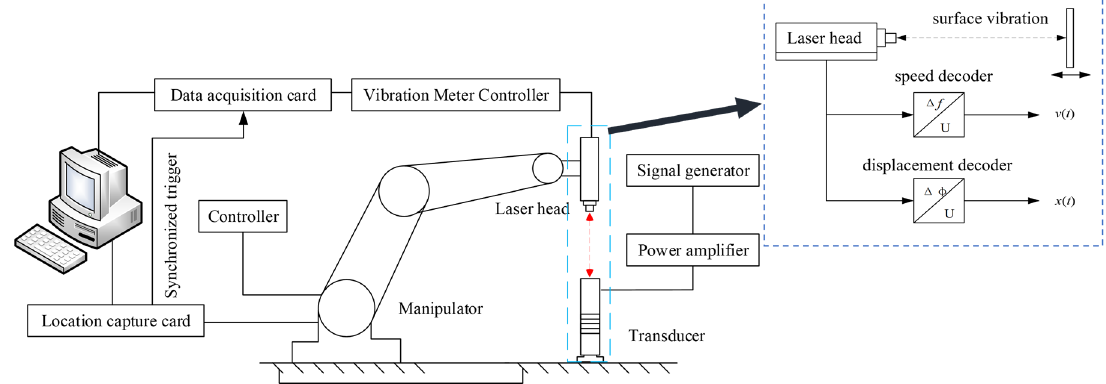
Figure 6. Working state measurement system of sandwich transducer.